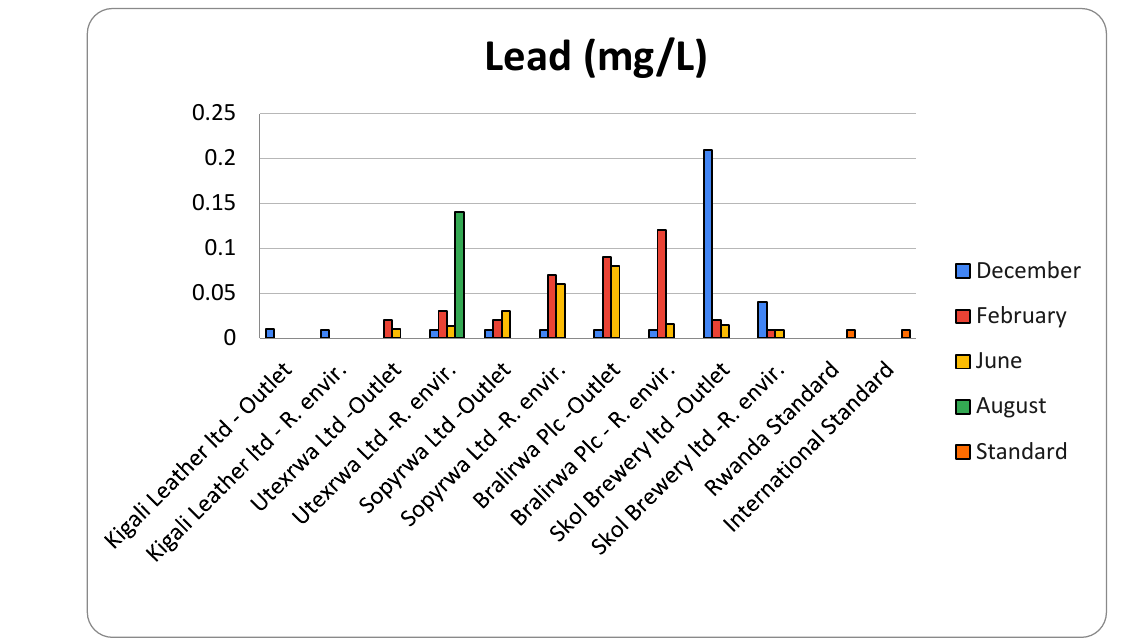
Figure 7. Lead discharge levels per site .